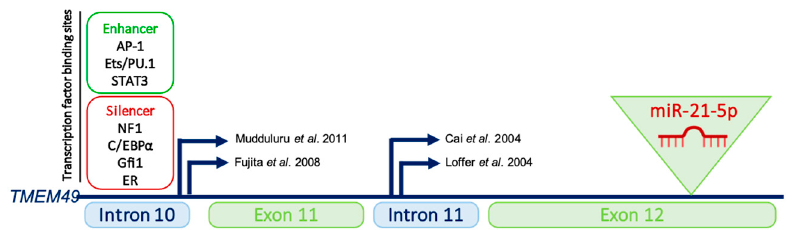
Figure 2. Genomic location of pri-miR-21. Gene encoding pri-miR-21 is located on chromosome 17q23.2 and overlaps with TMEM49, a coding gene. Two distinct transcriptional start sites with respect to the miR-21 hairpin have been described and are indicated by bent arrows [13–16]. Binding regions for transcriptional activators (AP-1, Ets/PU,1 and STAT3) and repressors (NFI, C/EBP α , Gfi1 and ER) are also shown.